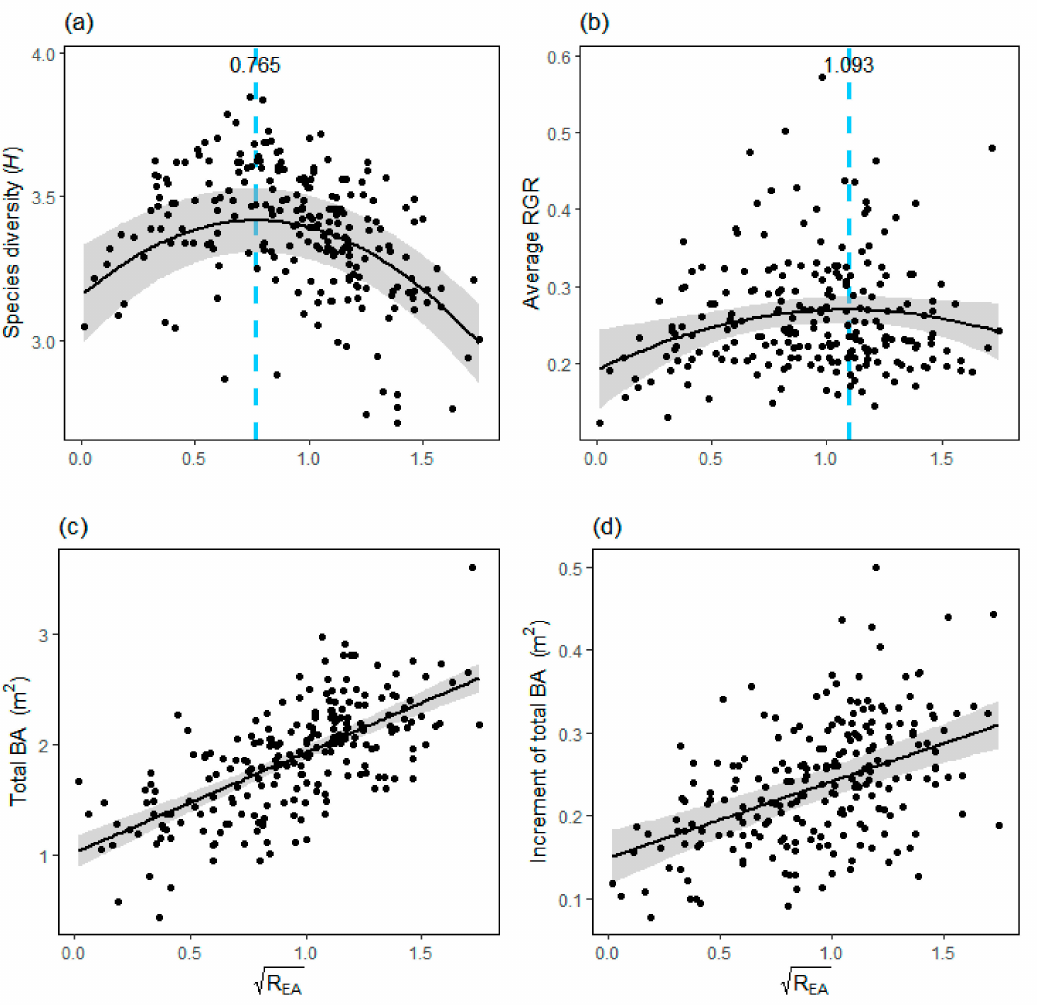
Figure 4. Correlations between the square root of R EA with species diversity ( H , Shannon–Weiner index) ( a ), average RGR ( b ), total BA ( c ) and increment of total BA ( d ). RGR, relative growth rates; BA, basal area; R EA , the ratio of BA of EcM to BA of AM tree